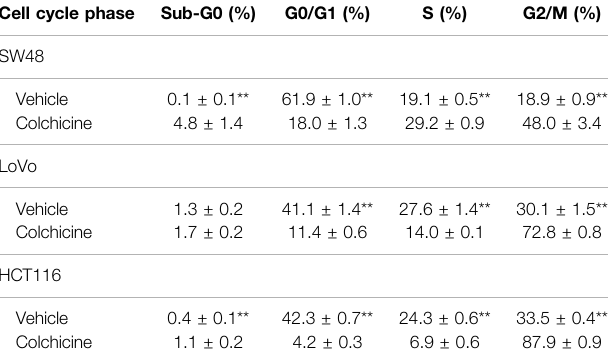
TABLE 1 | Cell cycle analyses in colchicine-treated colorectal cancer